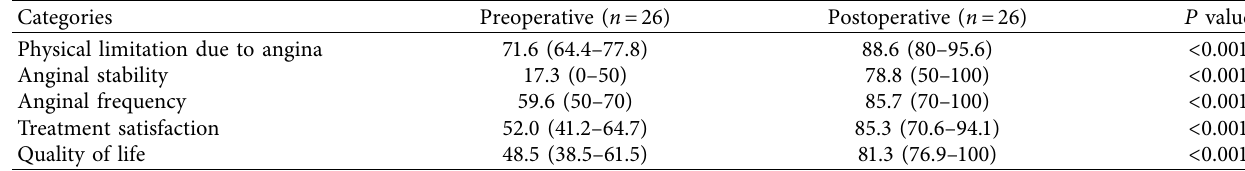
Table 3: Seattle Angina Questionnaire Scores before and after unroofng in the conventional group.